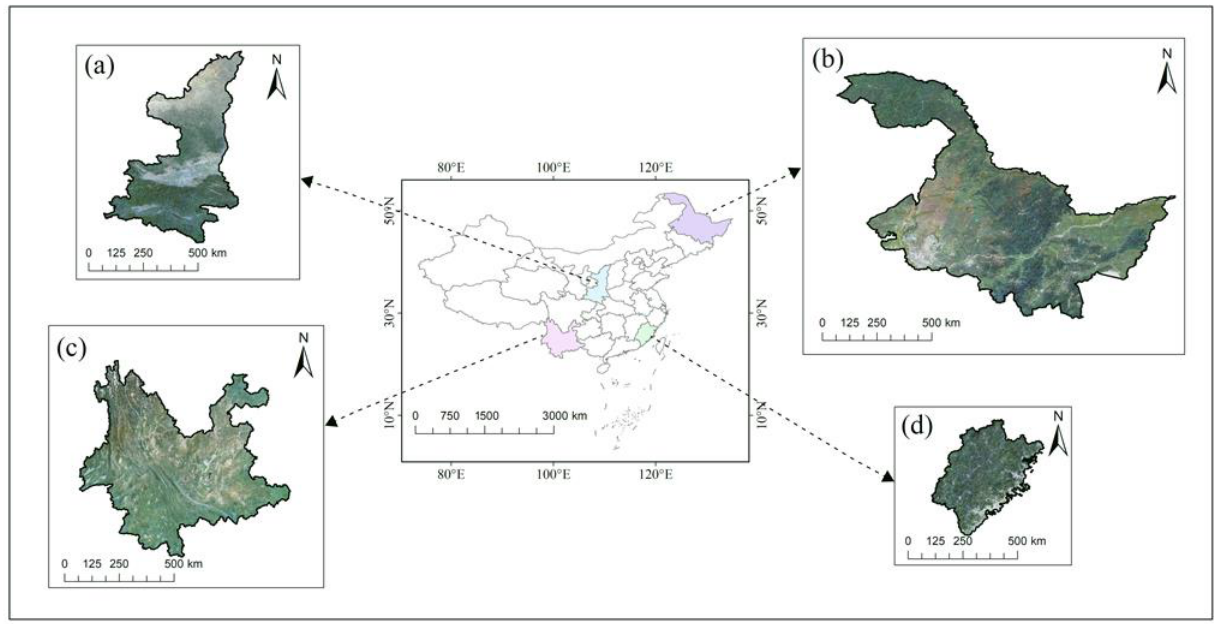
Figure 1. Spatial patterns of the study area. ( a ) Shaanxi province; ( b ) Heilongjiang province; ( c ) Yunnan province; and ( d ) Fujian province. Remote sensing images of the four provinces came from the Landsat 8 OLI data.